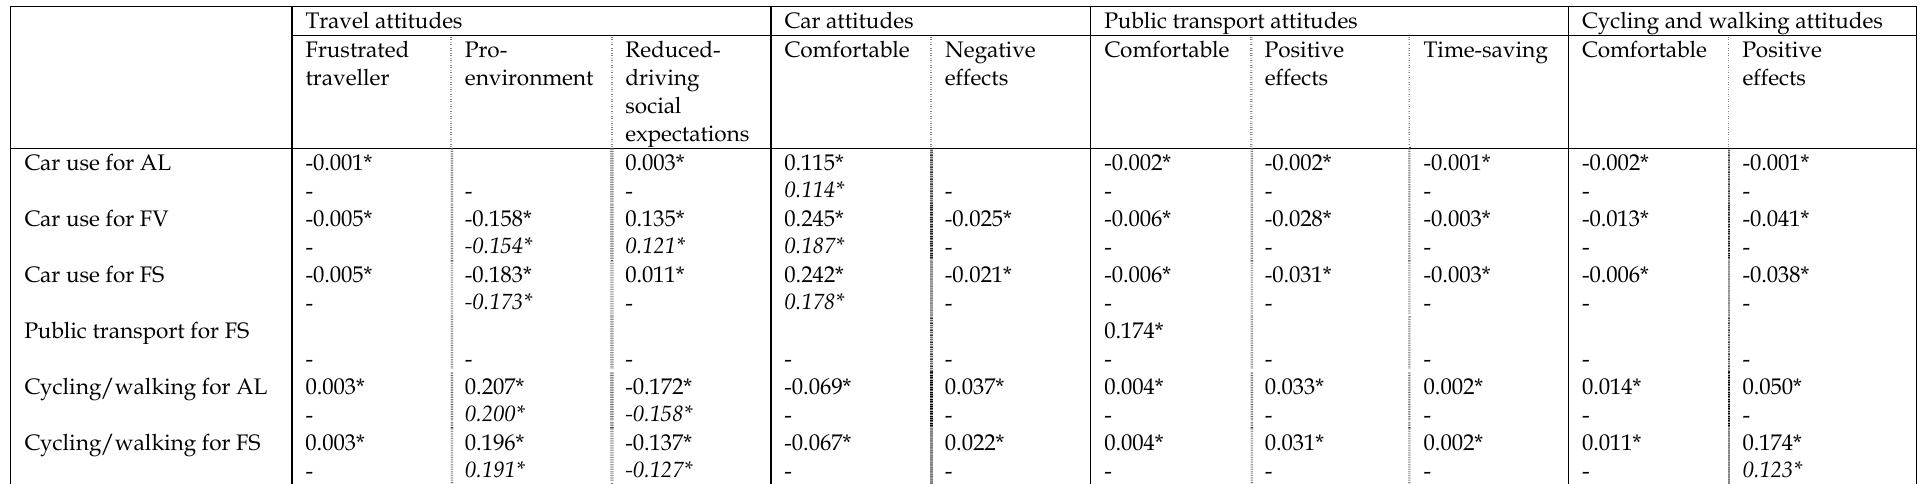
Table 4. Standardized direct and total effects on travel (mode)